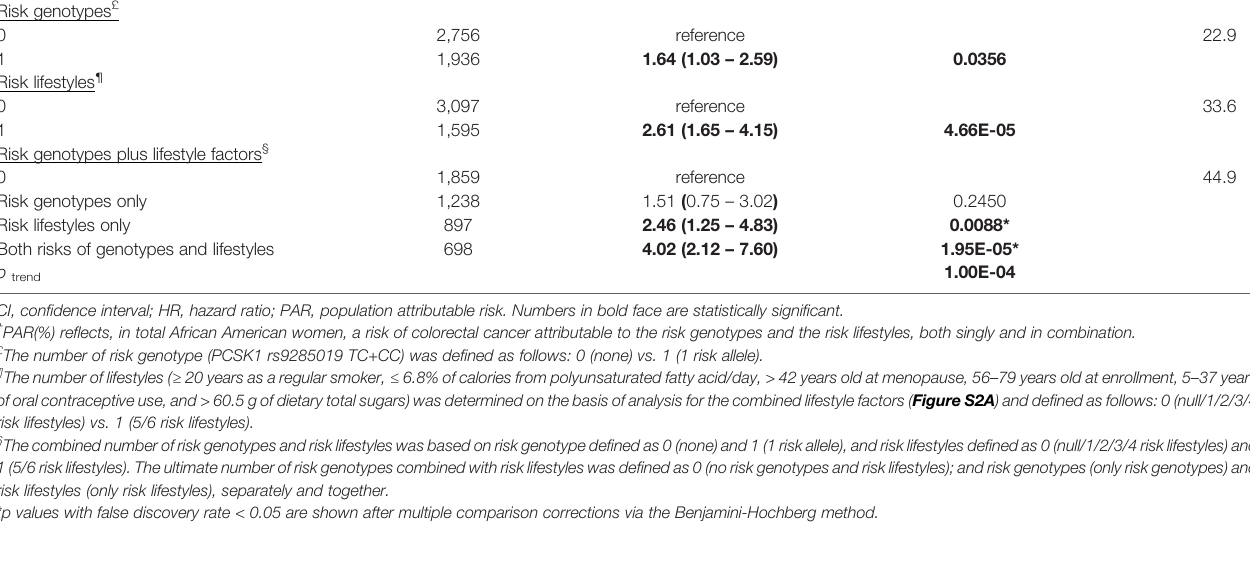
TABLE 2 | African American women: combined effect of risk genotypes and risk lifestyles on colorectal cancer risk and population-attributable risk percentage. Number of